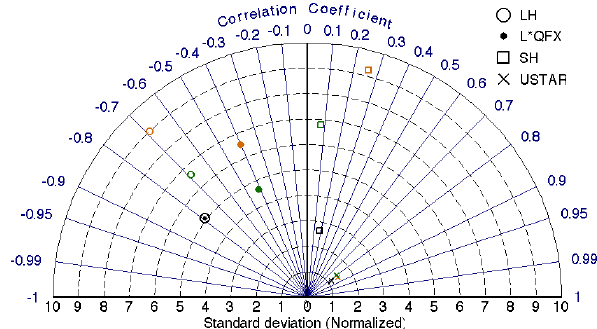
Fig. 17. Taylor diagrams summarizing the normalized standard de- viation and the correlation coefficient for each of the variables in Fig.